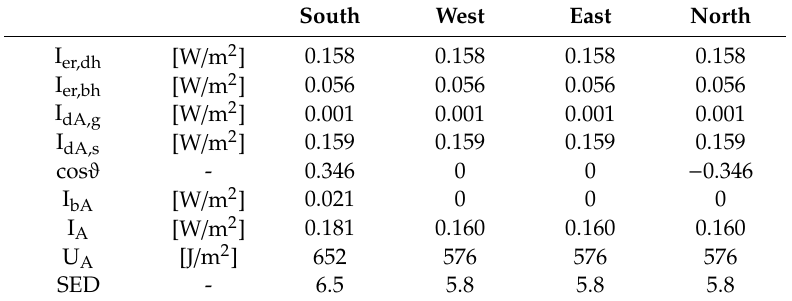
Table 3. Calculation results for vertical surfaces facing the four cardinal points (21 June, solar noontime).